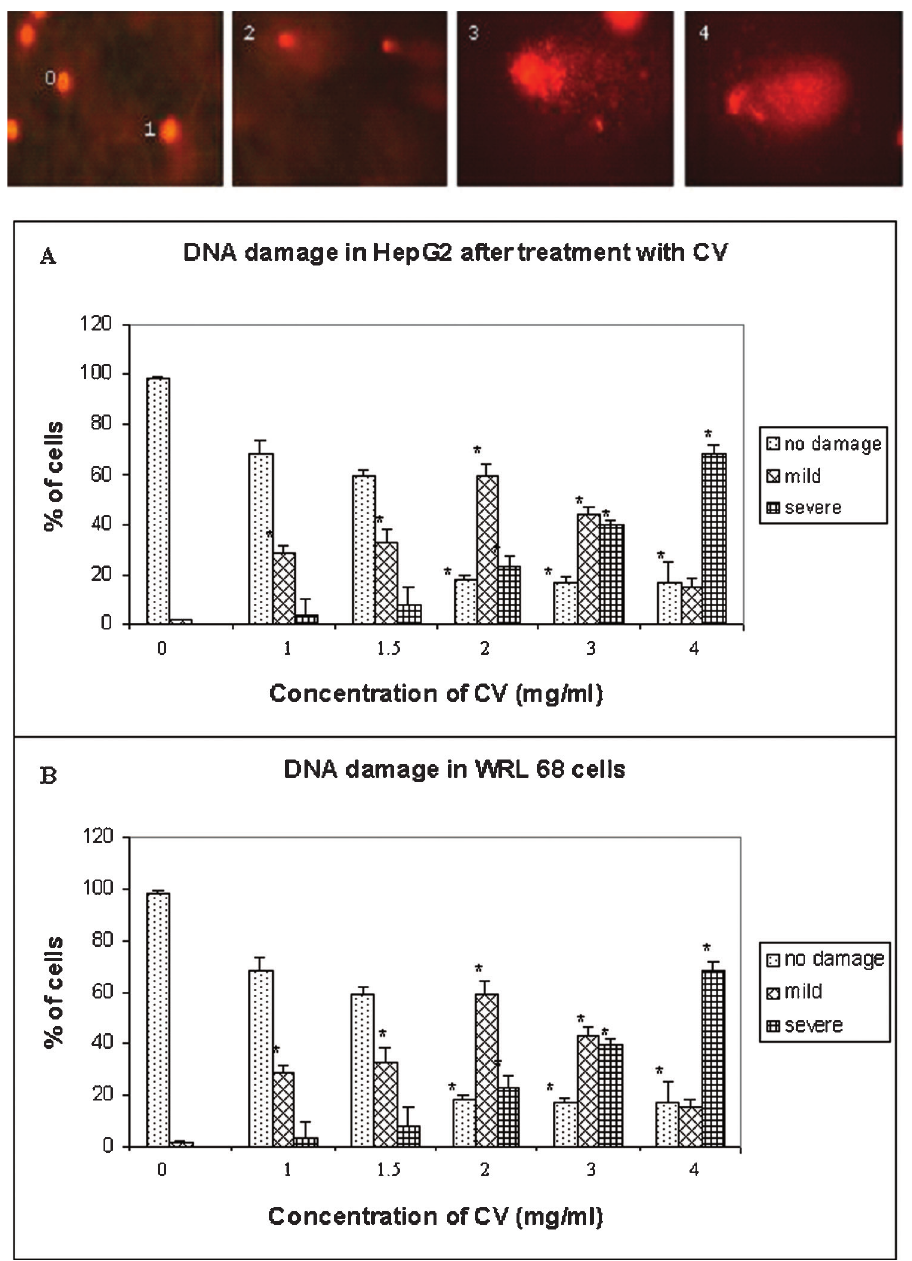
Figure 5 - Detection of DNA damage in HepG2 and WRL68 cells as measured by Comet assay after 24 hours treatment with Chlorella vulgaris . Data are represented as mean ¡ SD for n=3 triplicate after 24 hours of treatment with C. vulgaris extract. (a) HepG2 cells treated with hot water extract of local C. vulgaris . (b) WRL68 cells treated with hot water extract of local C. vulgaris . Inset above the diagram shows representative image of a Comet generated in the single cell electrophoresis assay (Comet assay). 0 – cell without